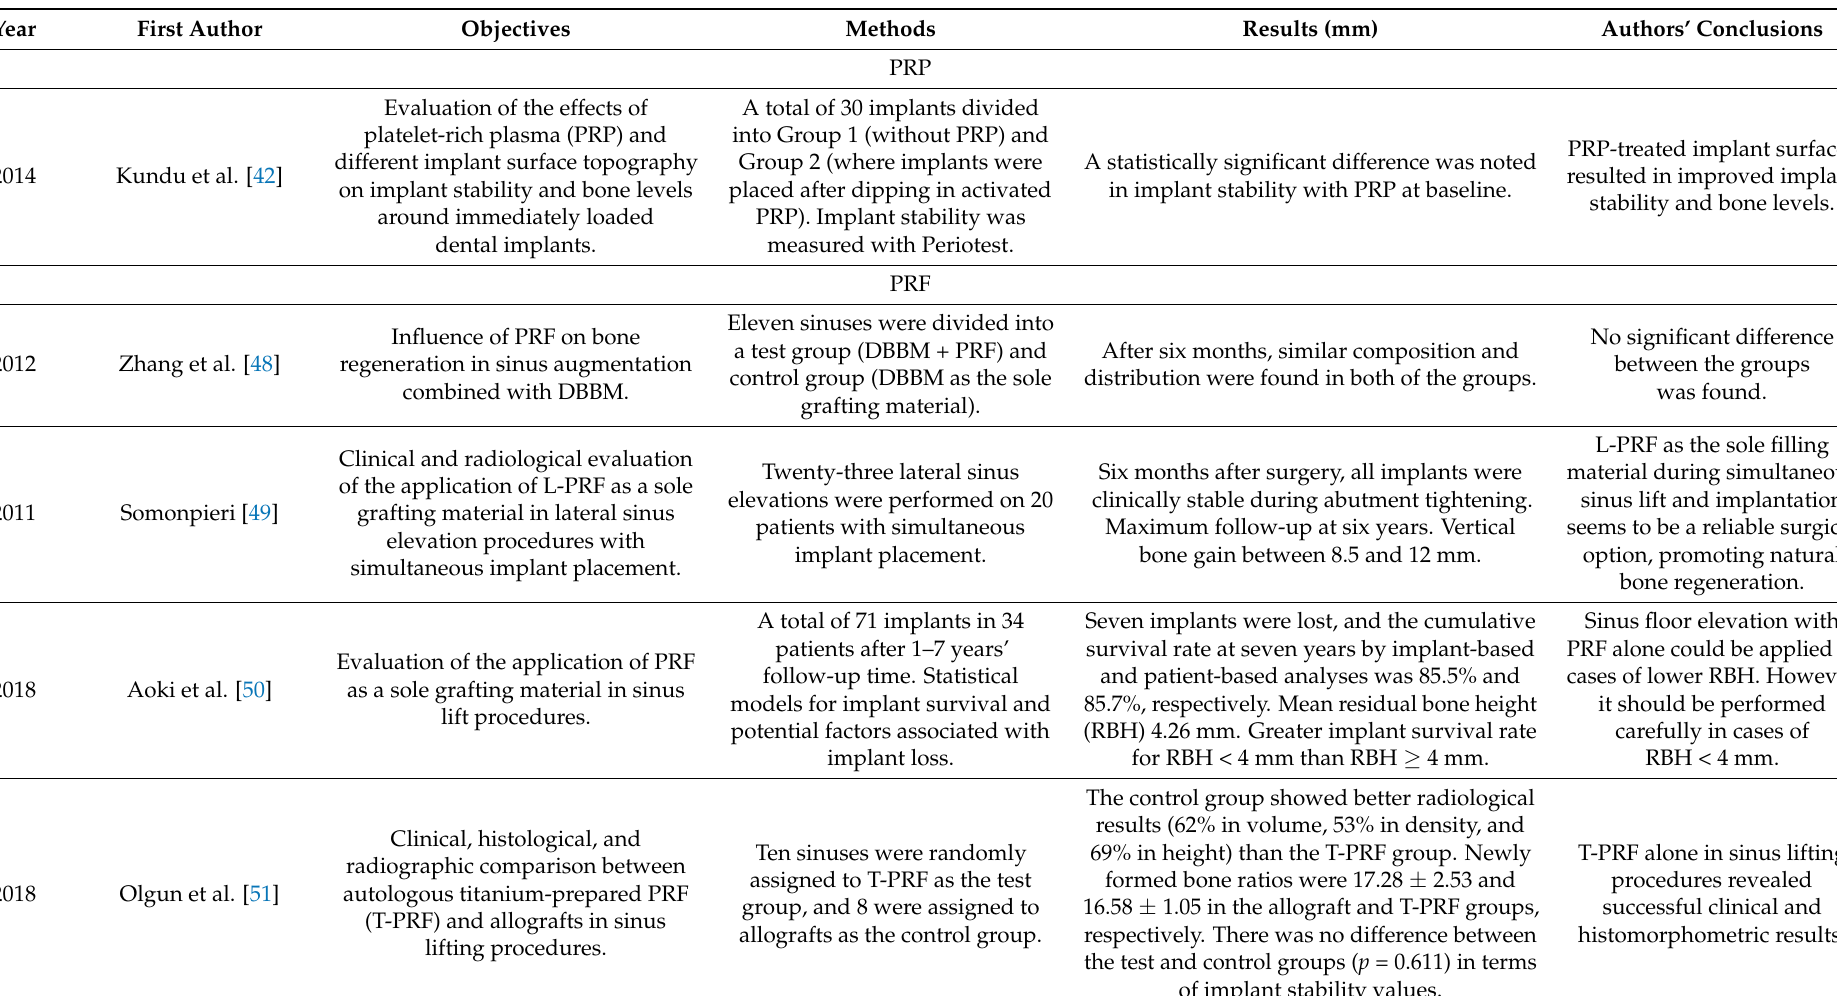
Table 2. Comparison between the 3 APC techniques (PRP, PRF, and CGF) in sinus